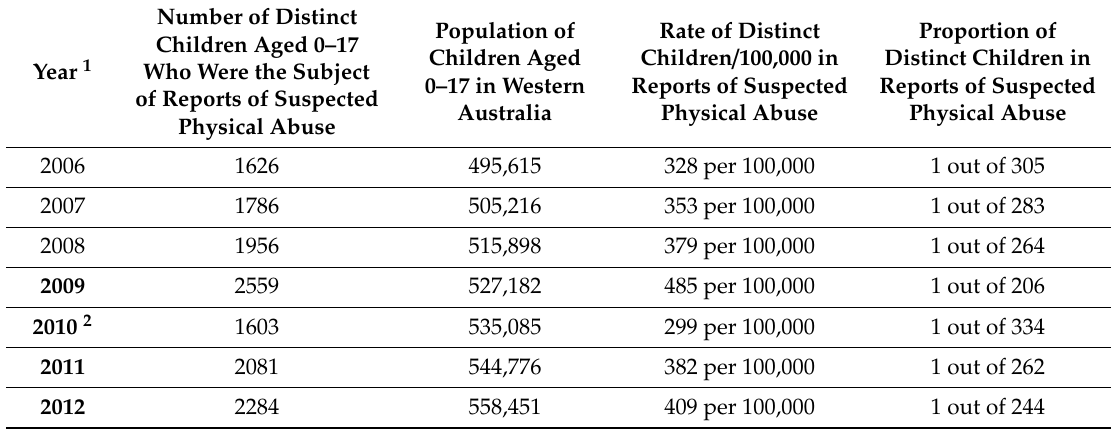
Table 3. Number and rate of children in reports of child physical abuse: Western Australia 2006–2012.